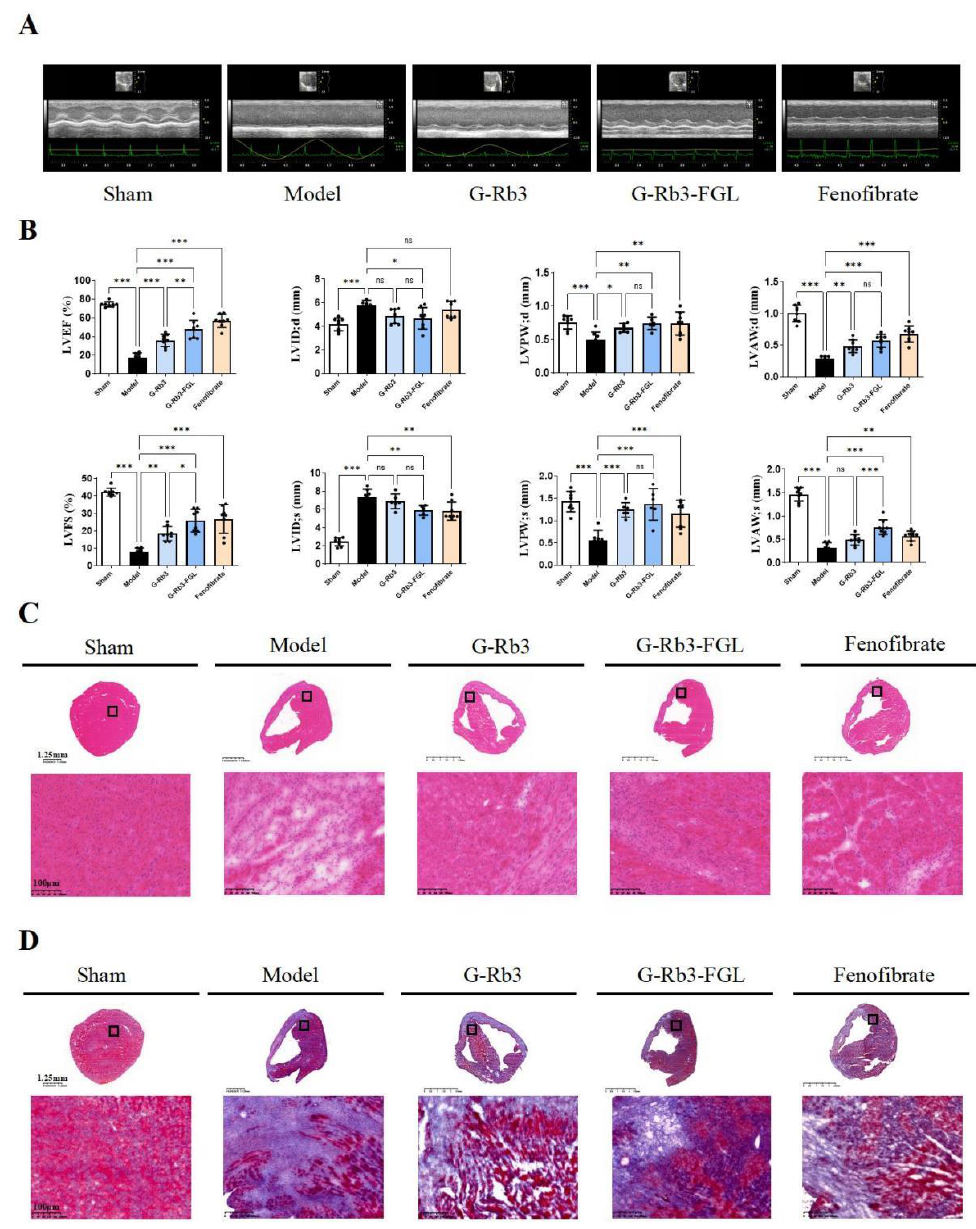
Figure 1. G-Rb3-FGL co-treatment improved heart function and ameliorated pathological changes in MI mice. ( A , B ) Echocardiographic analysis. The levels of LVEF, LVFS, LVID; d, LVID; s with G-Rb3, G-Rb3-FGL treatment were recorded by echocardiography. ( C , D ) H&E and Masson staining. ns No statistical significance, * p < 0.05, ** p < 0.01, *** p < 0.001 vs. model group. N = 8 per group.